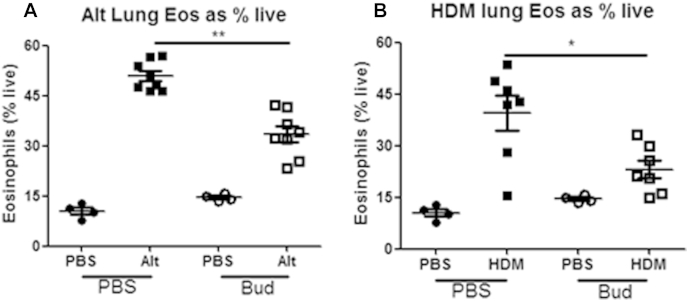
Neonatal BALB/c mice were exposed to intranasal saline (PBS), HDM, or A alternata (Alt) from day 3 of life for 3 weeks, with concomitant intranasal budesonide (0.6 mg/kg) or PBS from day 10 of life for 2 weeks (prevention regimen). These data relate to the same experiment shown in Fig 5. Numbers of eosinophils were quantified by means of flow cytometry in lung digests after A alternata exposure (A) and HDM exposure (B) with and without budesonide (Bud; n = 4-6 per group for PBS and n = 6-8 per group for HDM or A alternata. *P < .05 and **P < .01.